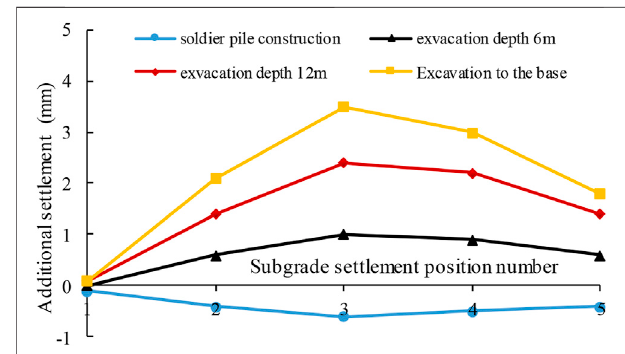
FIGURE 4 | Numerical model and calculation mesh. FIGURE 5 | Cumulative settlement of the